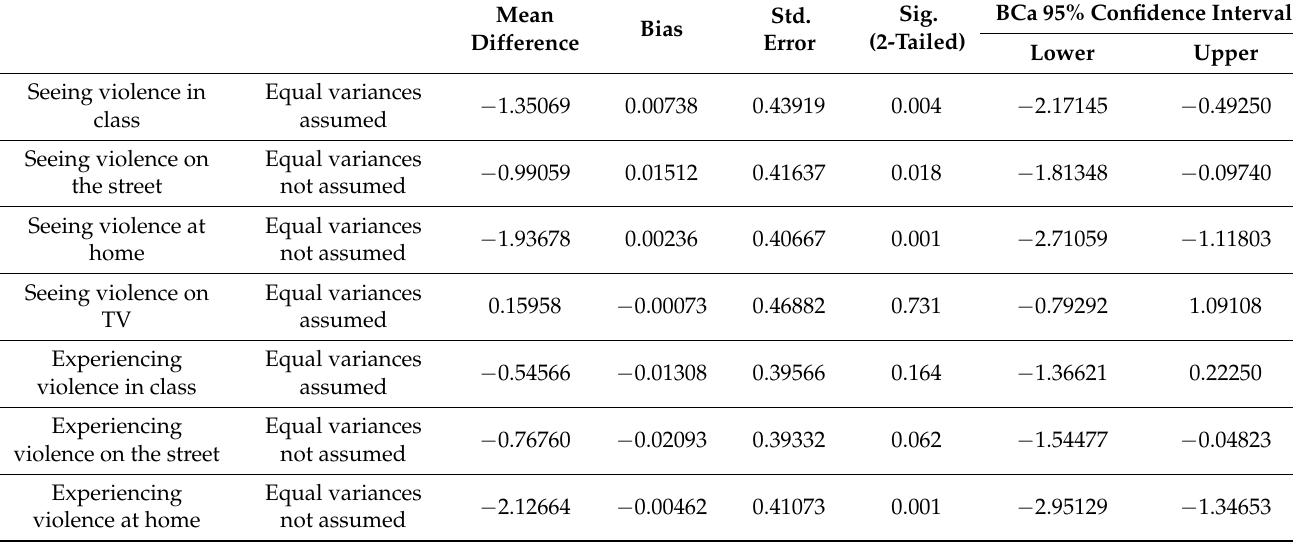
Table 1. Bootstrap a for Independent Samples Test (DVs = seeing and experiencing violence; IV = CPV or not CPV). BCa 95% Confidence Interval Sig. Mean Std. Bias (2-Tailed) Difference Error Lower